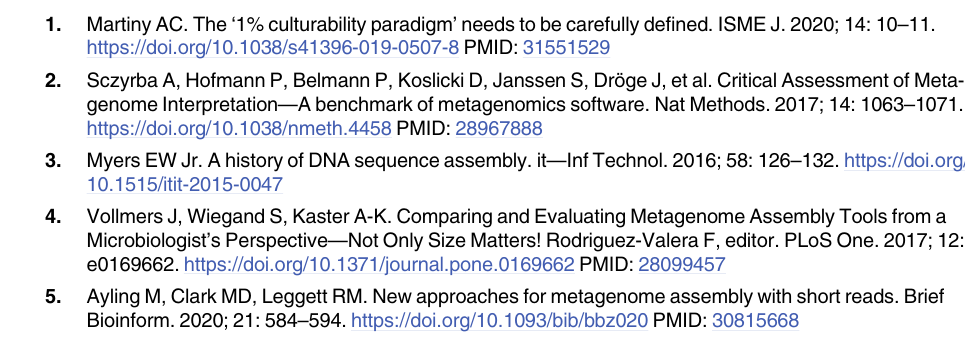
S3 Table. MetaBat 2 Bin Information. We applied Jorg to the bins by using a subsample of the reads because the original dataset was very large. Completeness and contamination were calculated by CheckM using the lineage workflow. For the MetaBat 2 bins, we did not apply Jorg to Bin 3 because of its small size and we did not apply Jorg to Bin 6 because it is comprised of contigs from the 2 yeast genomes (note that the GTDB-Tk classification is incorrect, likely because it does not look for eukaryotic